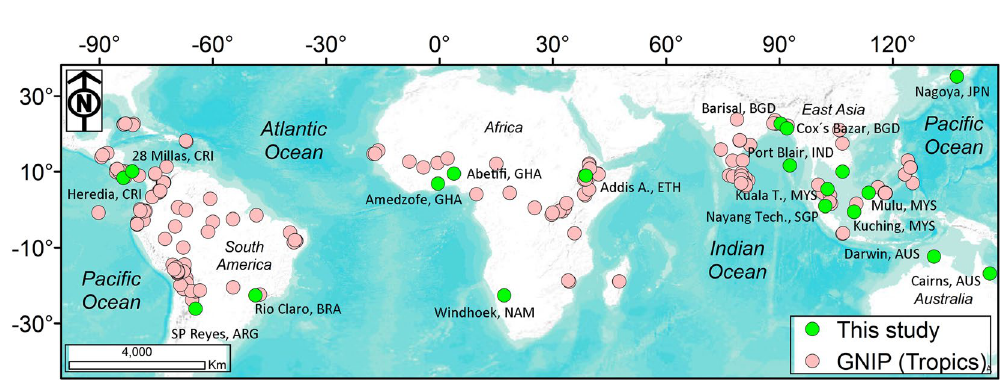
Figure 1. Map of the 19 sampling stations (green dots) and 229 GNIP (Global Network of Isotopes in Precipitation) tropical stations (pink dots; ranging from 23.76°N/23.83°S and 90.30°W/125.26°E). Geographical coordinates for stations of this study are provided in Table